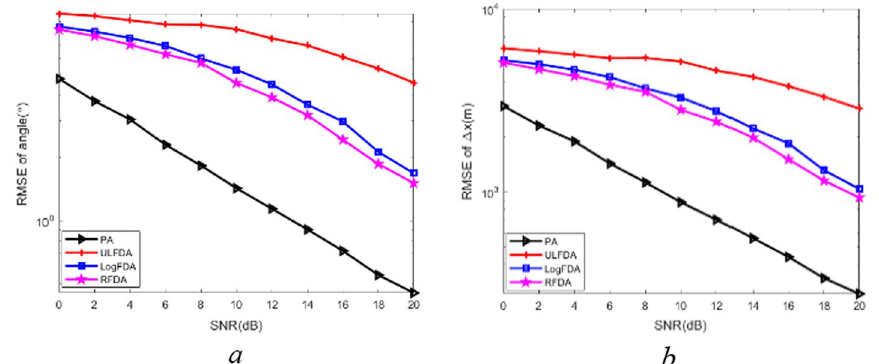
Fig. 8 Estimation RMSE with SNR. a DOA RMSE and b Location